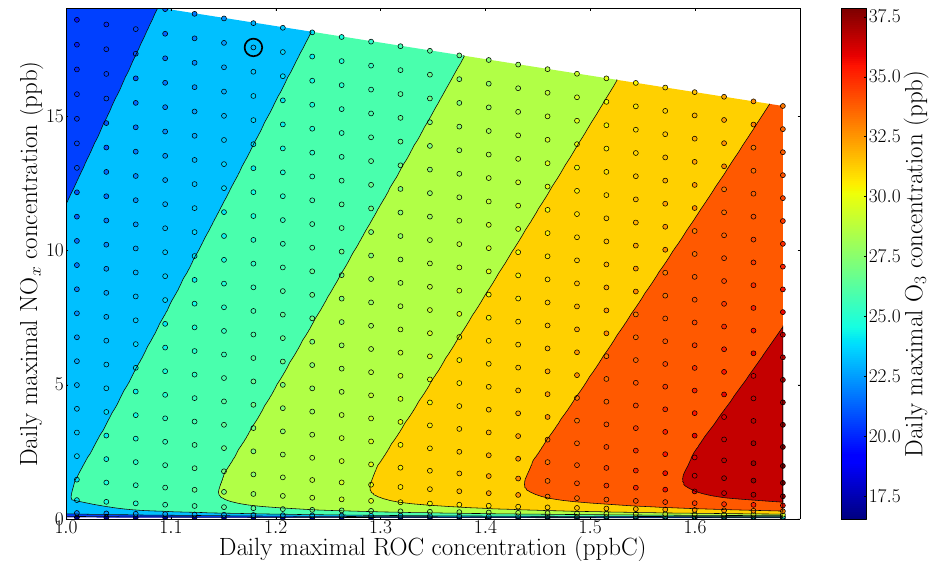
Figure 2. Maximal ozone concentration (in ppb) averaged over the domain depending on maximal averaged ROC (in ppbC) and NO x concentrations (in ppb). Each dot corresponds to a run with a different emission rate for ROC and NO x , leading to different maximal averaged concentrations. The reference run is circled in